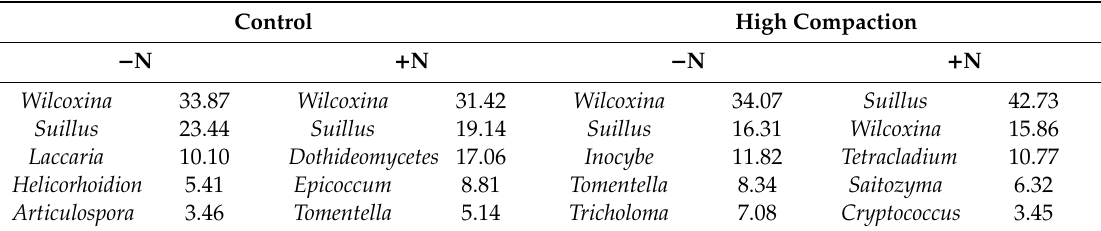
Table 4. Results of relative abundance (%) for top five in associated ECM under soil compaction and N loading ( n = 5). The identified fungal taxa were described as genus